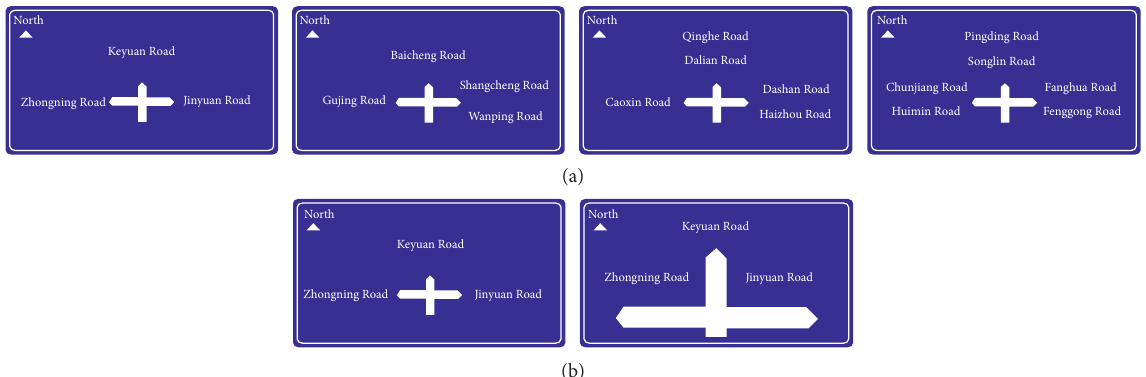
Figure 2: Examples of guide signs: (a) the amount of information of guide signs; (b) the layout of guide signs (left panel: layout 1. right panel: layout